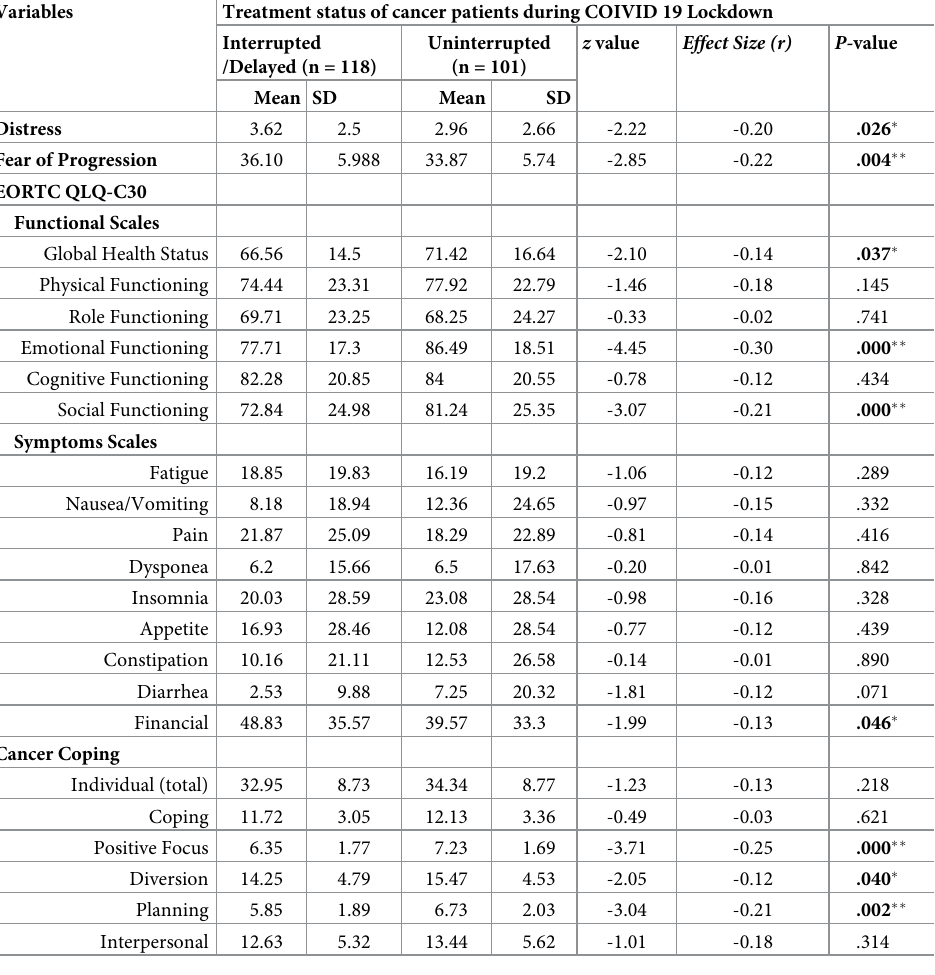
Table 4. Mean difference between the treatment status of cancer patients during COVID-19 lockdown and dis- tress, FOP, QOL and cancer